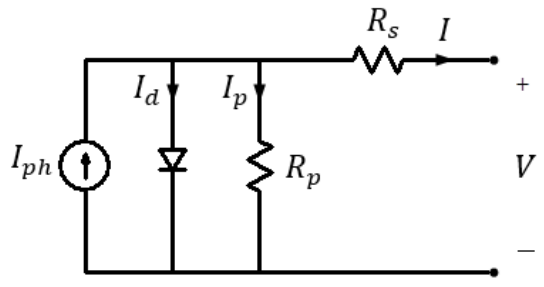
Figure 2. Solar cell single-diode equivalent circuit